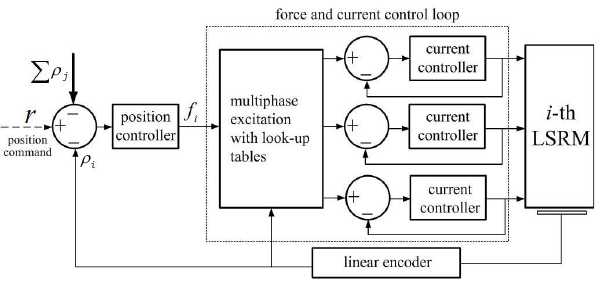
Figure 2. Control block diagram for the linear switched reluctance machine (LSRM)